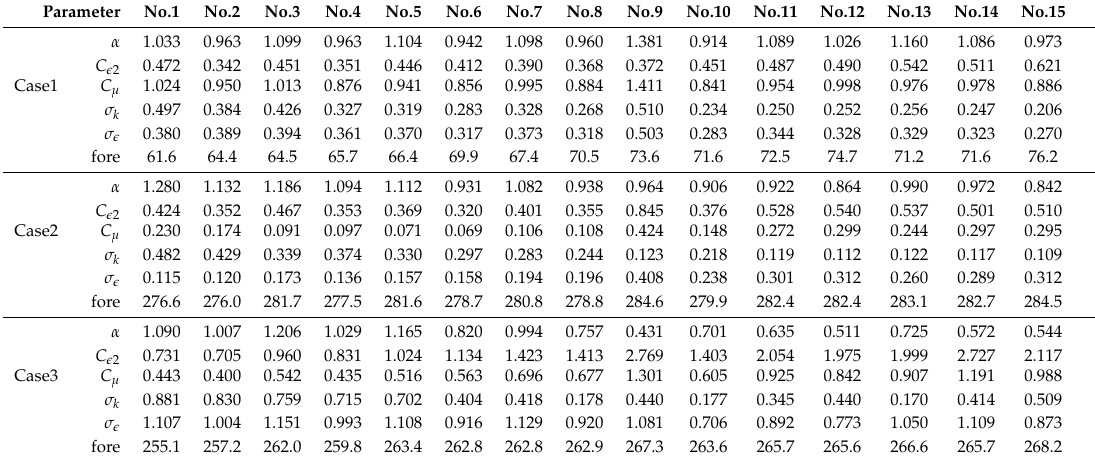
Table 5. The STD values of the wind direction ( ◦ ) for three cases at 15 turbine sites. The deterministic forecasts of hub height wind direction are also